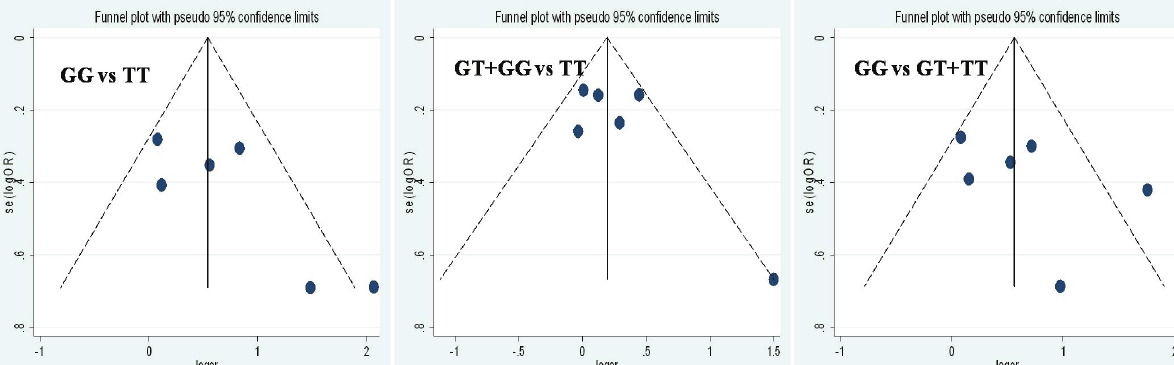
Figure 3: Forest plot of correlation between adiponectin gene rs22411766T>G polymorphism and ischemic stroke in GG vs GT+TT genetic model